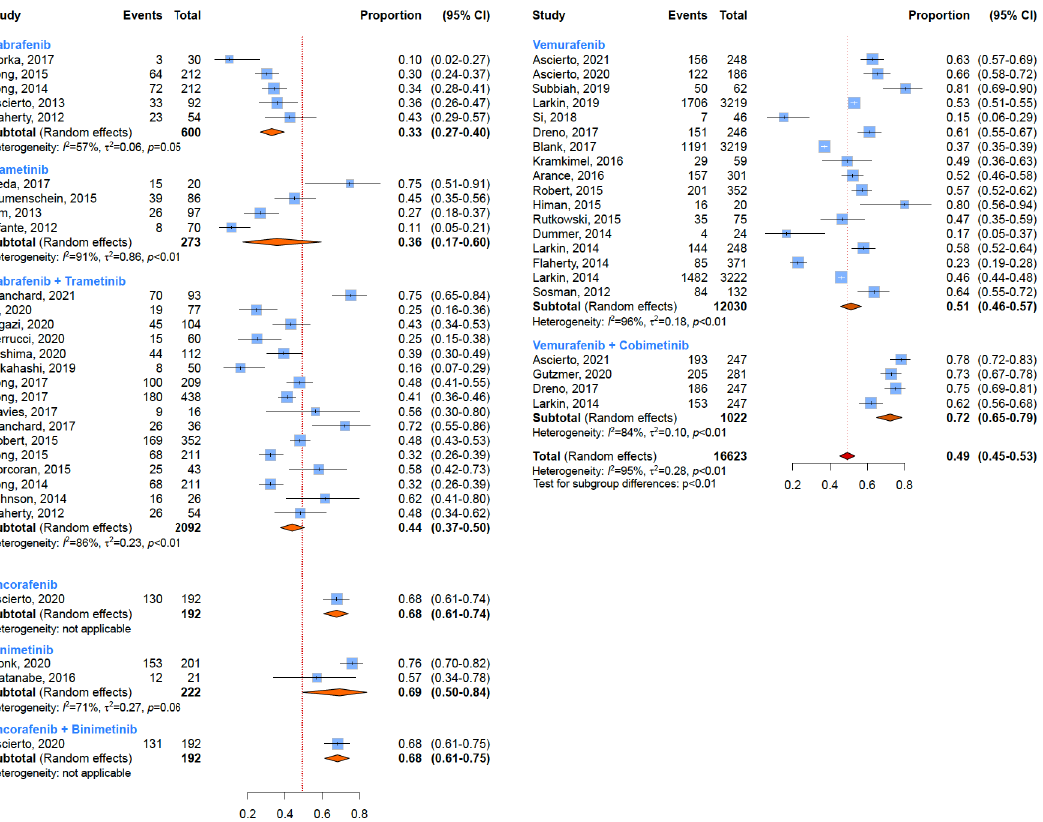
Figure 3. Overall incidences of all-grade adverse events for every treatment